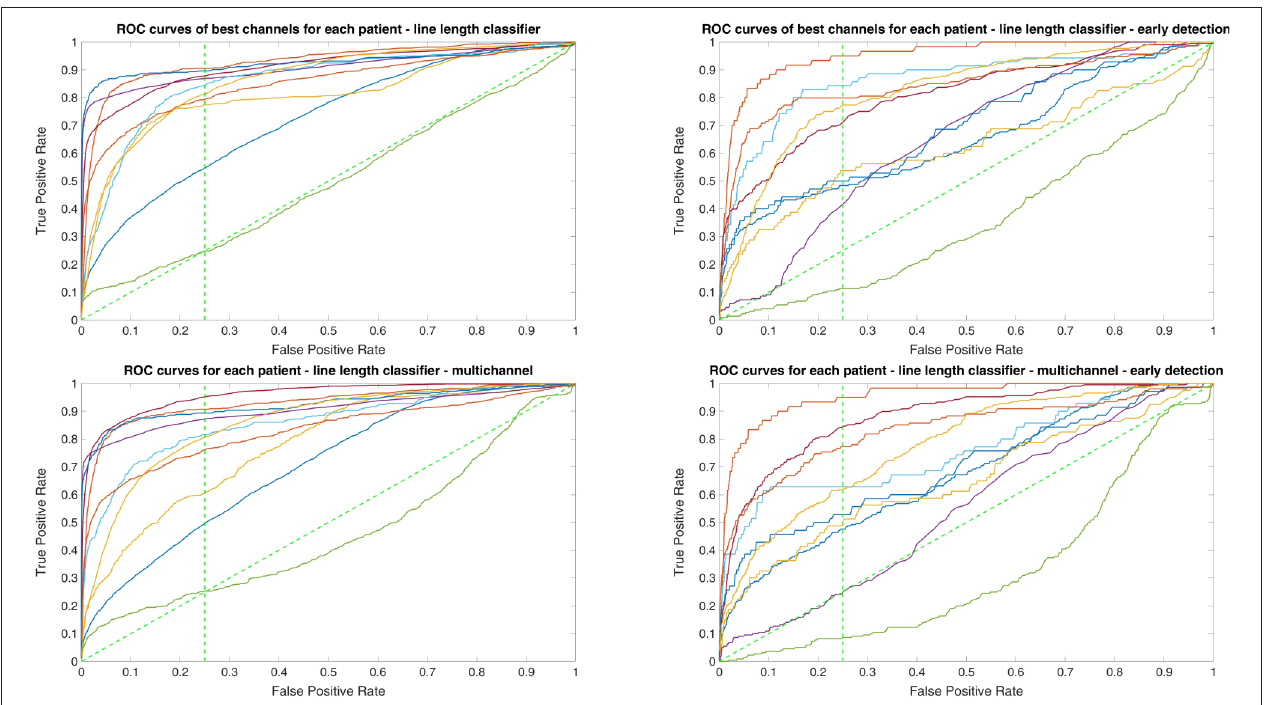
FIGURE 7 | ROC curves of all patients in single and multichannel mode for the line length classifier. The dashed line separates the early retrieval area.